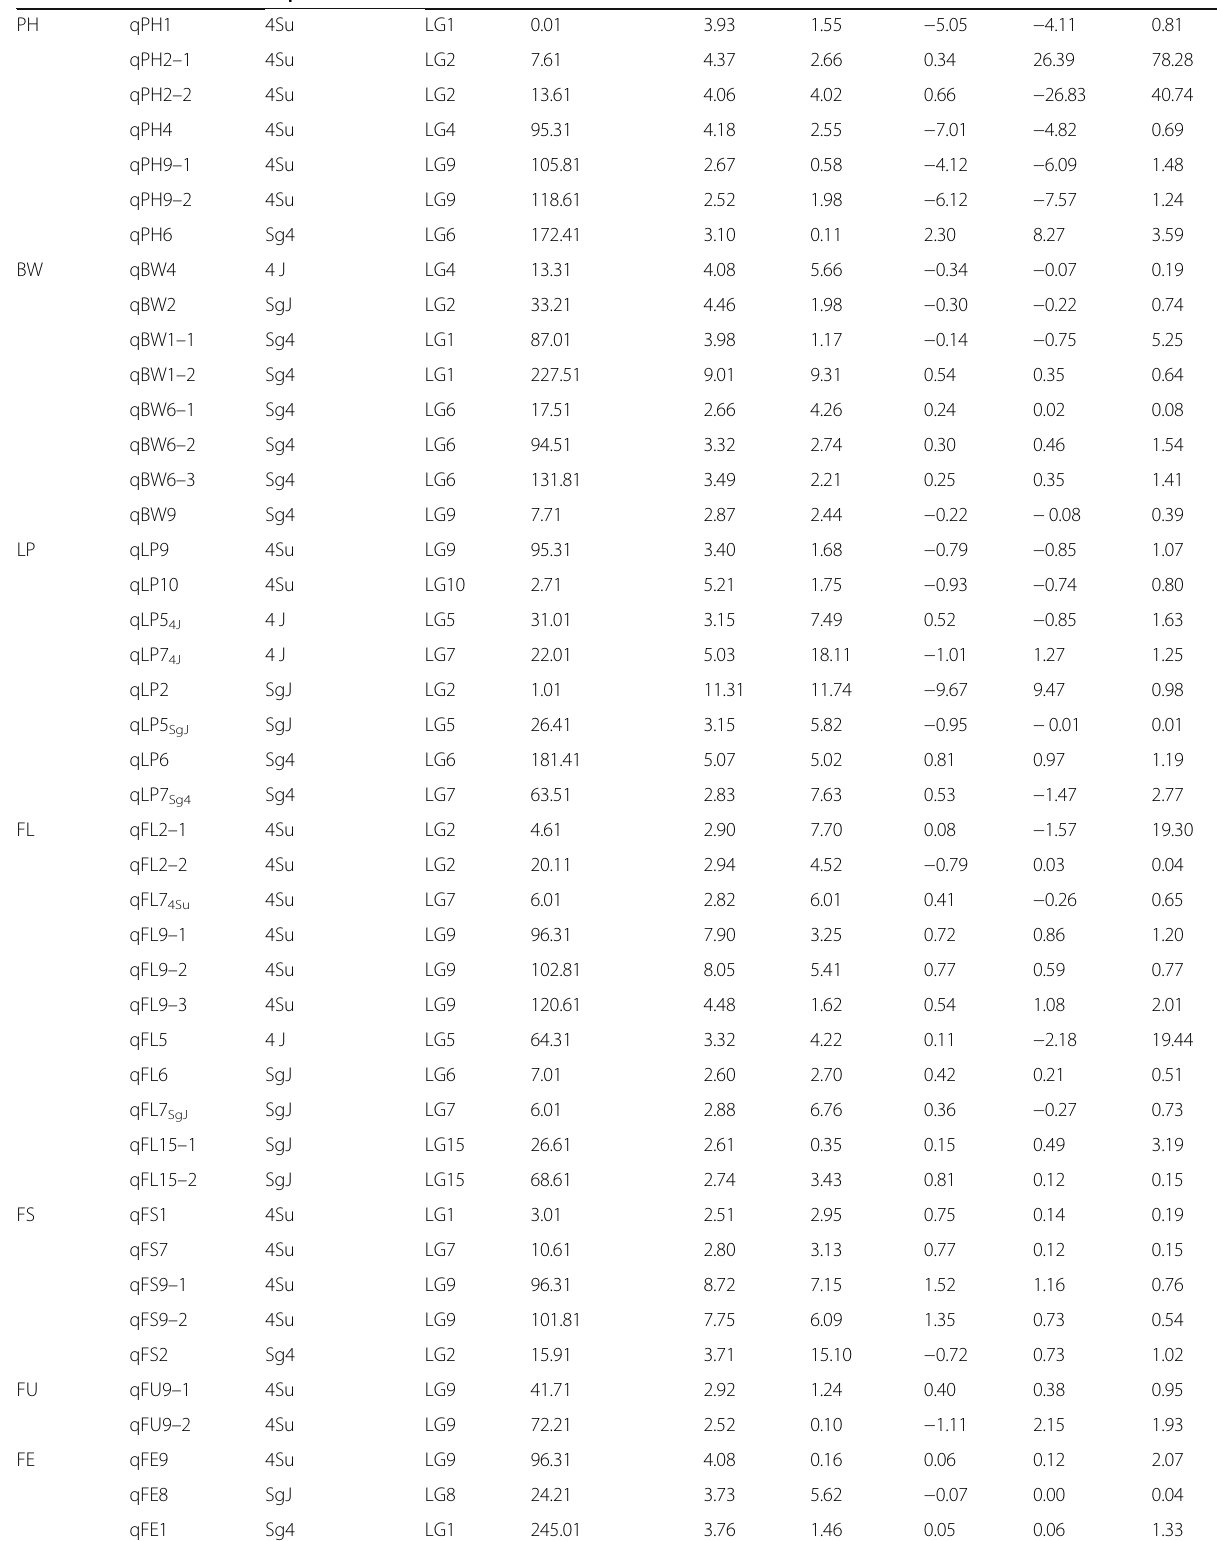
Table 3 Summary of QTLs identified in four populations for 8 traits